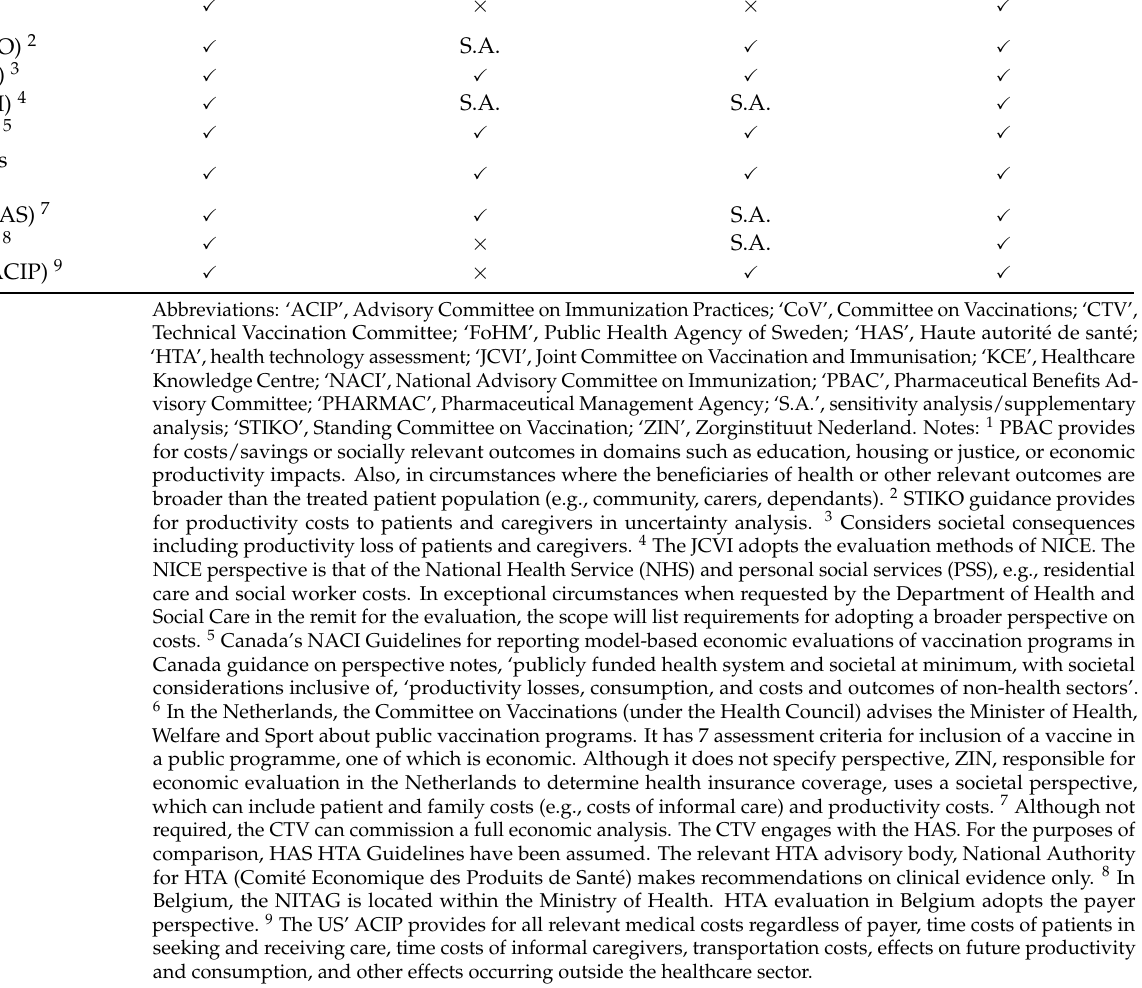
Table 3. Costs and outcomes included in the base case evaluation of vaccine interventions by international HTA agencies.